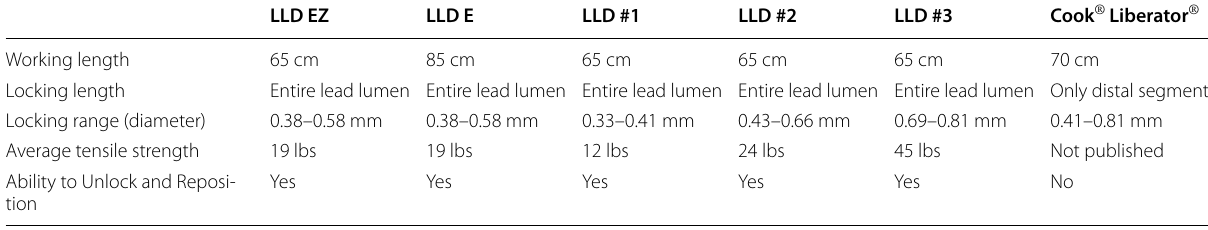
Table 2 Comparison of lead locking